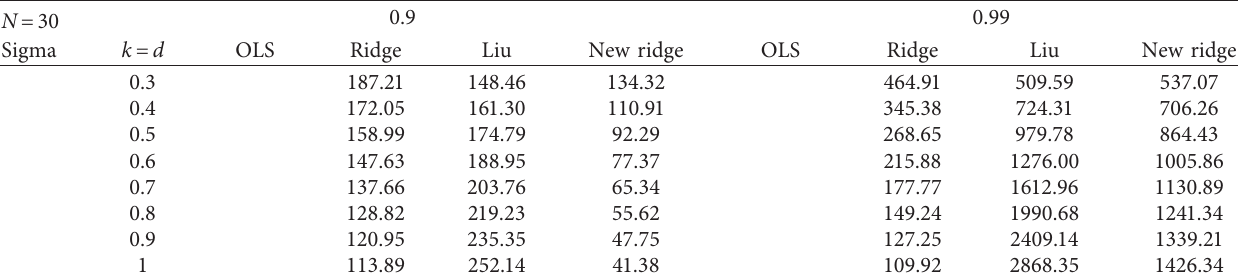
Table 7: Estimated MSE when n � 100, p � 7, and ρ � 0.70 and 0.80. n �